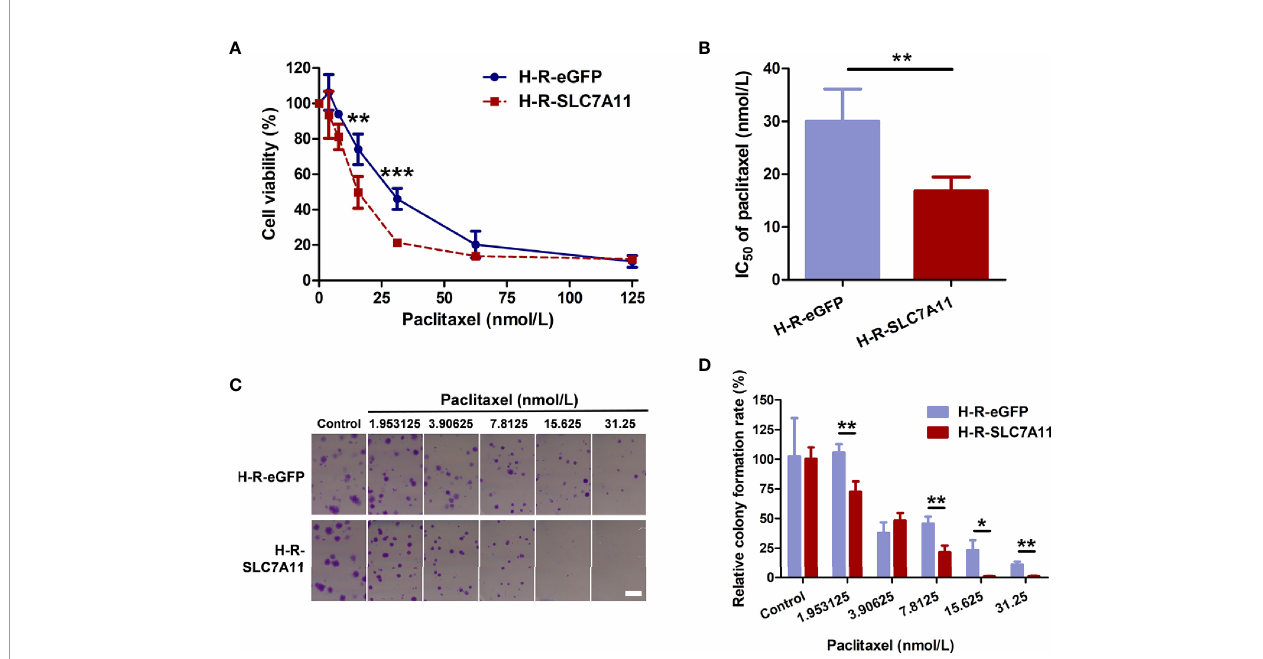
FIGURE 4 | SLC7A11-overexpressed HeyA8-R-SLC7A11 (H-R-SLC7A11) cells were more sensitive to paclitaxel than H-R-eGFP cells. (A, B) H-R-SLC7A11 and H-R-eGFP cells were treated with various doses of paclitaxel for 72 hours. The CCK-8 assay was used to reveal the cell viability and the IC 50 of paclitaxel. Values represented the mean ± SD of four independent experiments (** P < 0.01; *** P < 0.001); (C) Representative scan images of the colony formation assay. H-R- SLC7A11 and H-R-eGFP cells were treated with gradient of paclitaxel for 8 days. Scale bar: 4 mm; (D) The relative colony formation rates of H-R-SLC7A11 and H-R-eGFP were analyzed by Image J. Values represented the mean ± SD of three independent experiments (* P < 0.05; ** P <